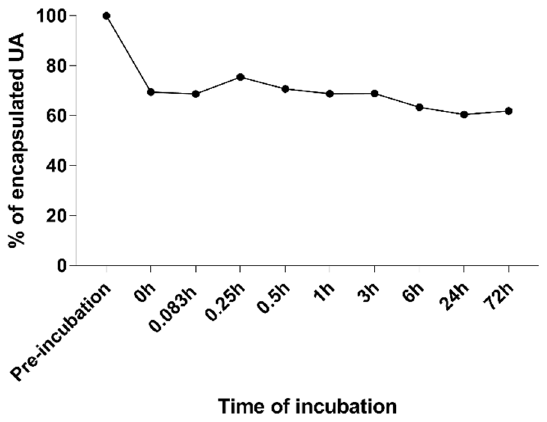
Figure 5. Stability of UA-S85-PLGA-PEG 2000 hybrid nanoparticles over 72 h of incubation with 50% solution of FBS: ( A ) change in the size of the nanoparticles, ( B ) change in PDI values of the nanoparticles.